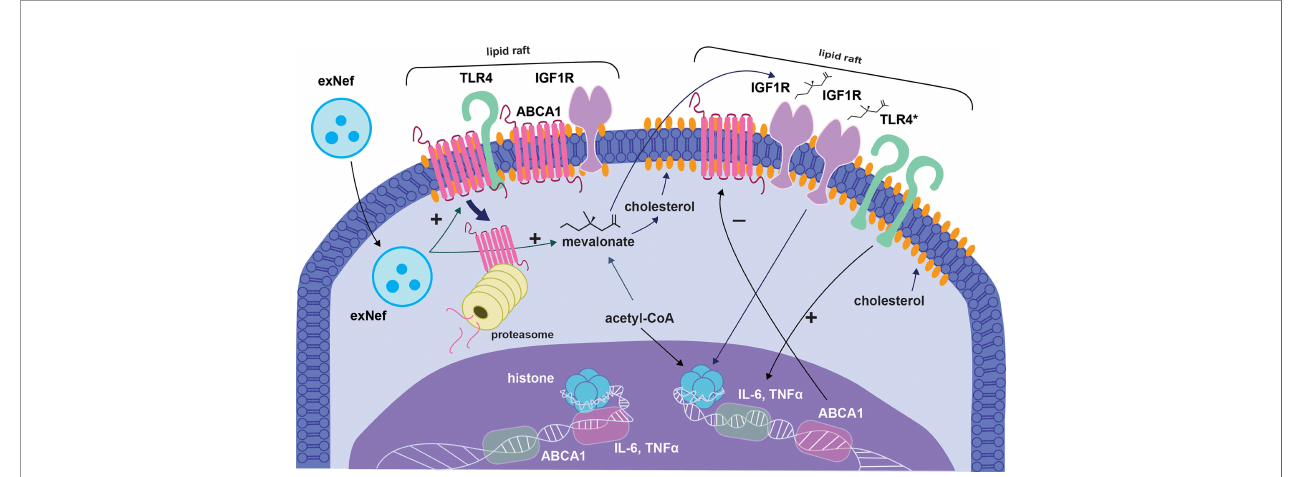
FIGURE 1 | Proposed model of trained immunity induced by exNef. The fi gure shows suggested sequence of events occurring when monocyte encounters Nef- containing extracellular vesicle (exNef). ExNef induces proteasomal degradation of plasma membrane ABCA1, modifying lipid rafts and increasing their abundance. Lipid raft changes promote dimerization and activation of TLR4 (TLR4* in the fi gure), which sends activating signal to in fl ammatory genes. Additionally, exNef stimulates glycolysis and cholesterol biosynthesis. One of the intermediate products of glycolysis, fumarate, is a negative regulator of the KDM5 histone demethylase, inhibition of which promotes trimethylation of the H3 histone on the K4 residue (H3K4me3). Another product of glycolysis, citrate, stimulates synthesis of Acetyl-CoA, which is a positive regulator of histone acetyltransferase and promotes acetylation of the H3 histone on the K27 residue (H3K27ac). Both modi fi cations are associated with transcriptionally active chromatin. These events lead to epigenetic modi fi cations resulting in sustained changes in lipid rafts and in fl ammatory cytokine production. ExNef also suppress ABCA1 maturation and delivery to plasma membrane, resulting in decreased ABCA1 and suppressed cholesterol ef fl ux. The cell becomes enriched in cholesterol, and the abundance of lipid rafts further increases, exacerbating events described above. An intermediate product of cholesterol biosynthesis, mevalonate, is secreted from the cell and stimulates the IGF1R, whose representation is increased on overabundant lipid rafts. Signaling from IGF1R stimulates the Akt-mTOR pathway, which further potentiates epigenetic remodeling. Histone modi fi cations alter expression of lipid raft regulating proteins (ABCA1 is shown as an example, switching from active to suppressed state) and pro-in fl ammatory cytokines (IL-6 and TNF switch from suppressed to active state). Epigenetic changes in lipid raft regulating genes ensure persistent ‘ activation ’ of the lipid rafts, whereas epigenetic modi fi cations of cytokine genes lead to overreaction to in fl ammatory stimuli. Together, these two mechanisms synergize to promote in fl